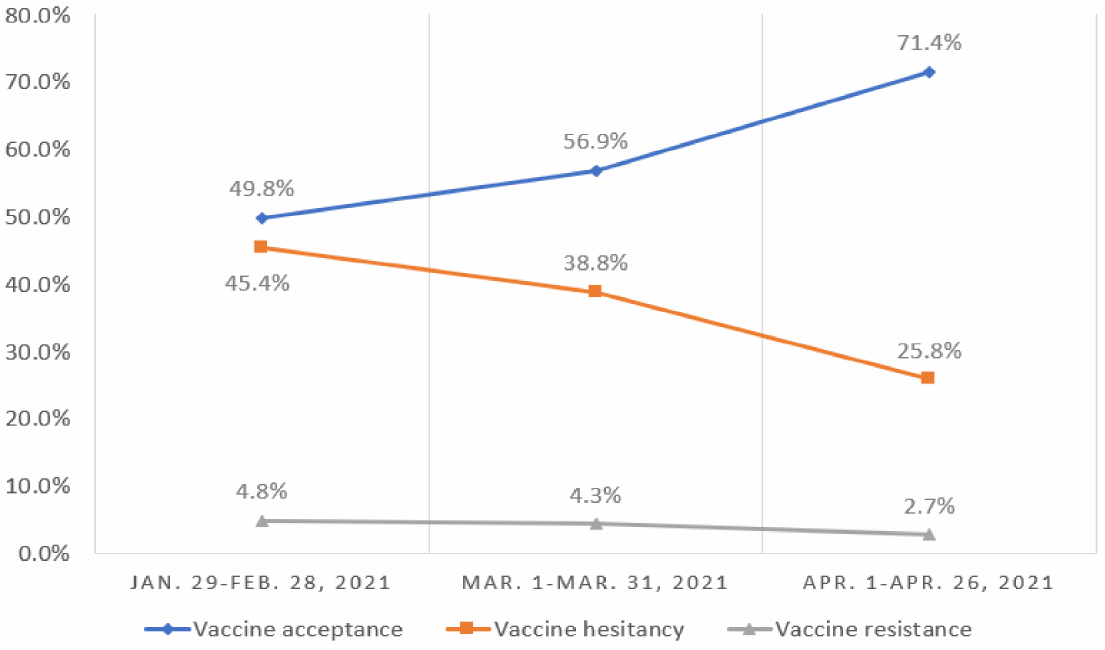
Figure 2. Change of willingness of vaccination against COVID-19 over